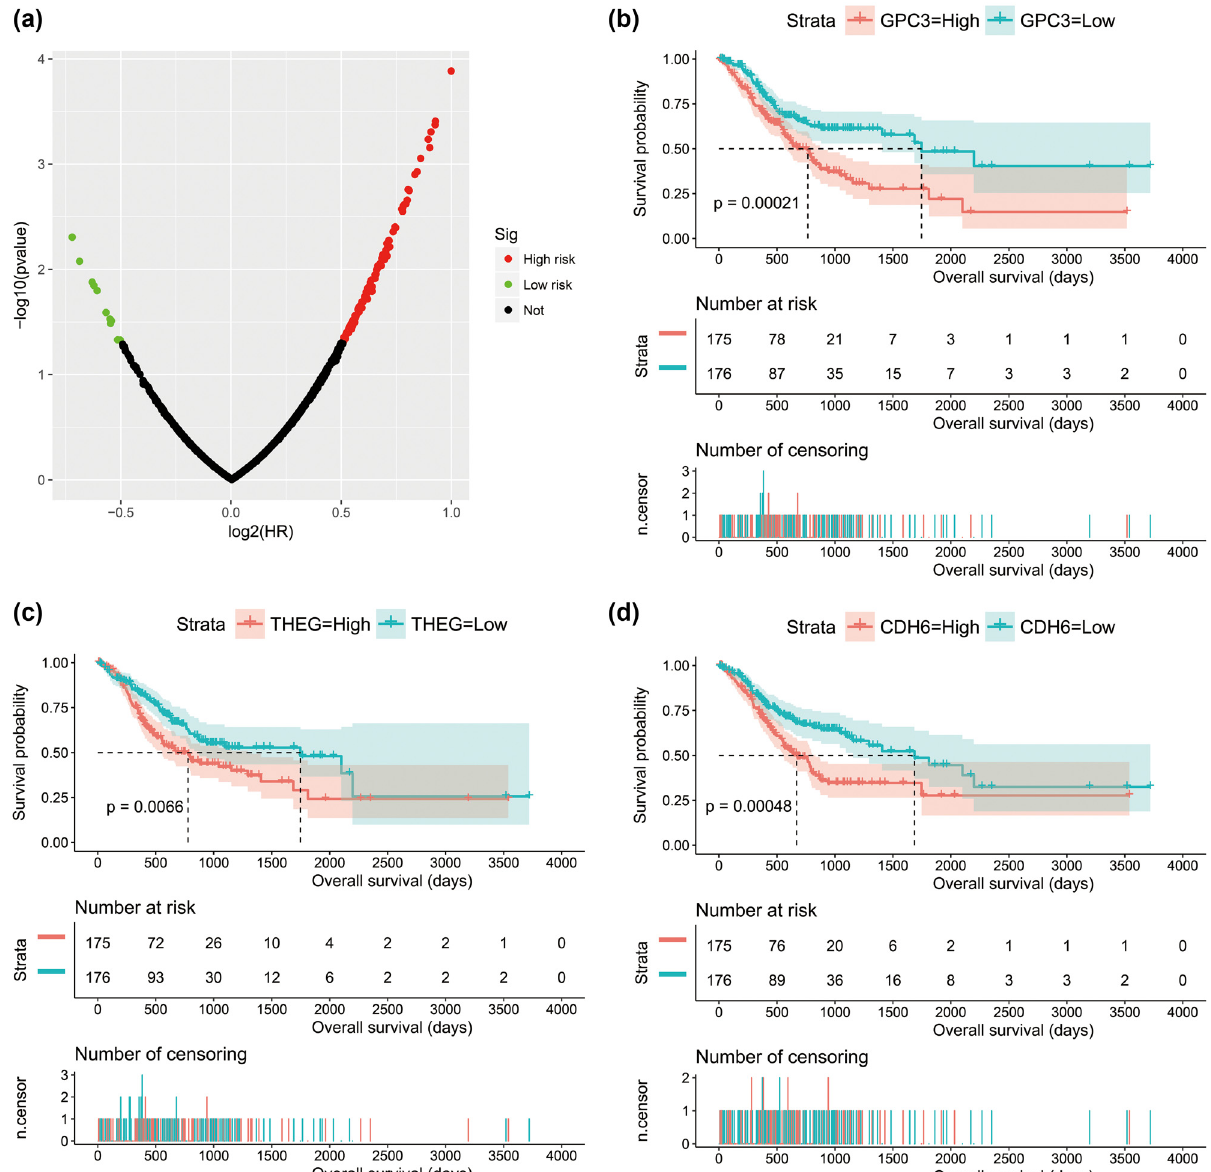
Figure 6: Survival analysis results of snRNA co - expressed genes: ( a ) volcano plot of survival analysis results; ( b ) Kaplan – Meier curve of glypican 3 ( GPC3 ) ; ( c ) Kaplan – Meier curve of theg spermatid protein ( THEG ) ; and ( d ) Kaplan – Meier curve of cadherin 6 ( CDH6 )